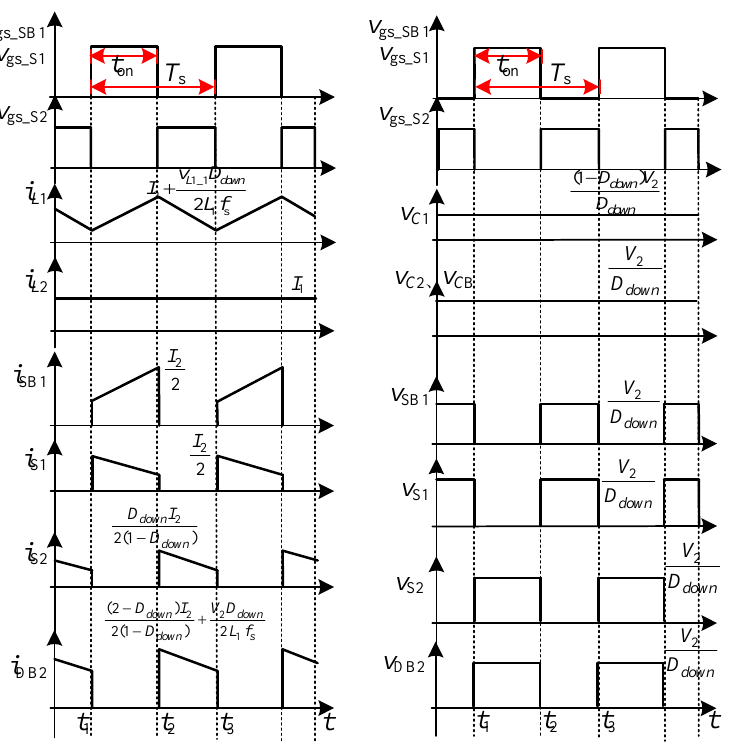
Figure 5. The equivalent circuit of the operation modes in step-down mode: ( a ) S B1 S 1 on, S 2 off; ( b ) S 2 on, S B1 S 1 off.